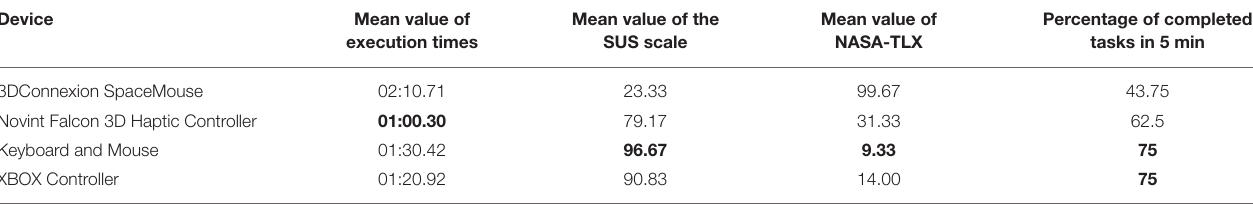
TABLE 1 | Averages of the results of the preliminary study, N =